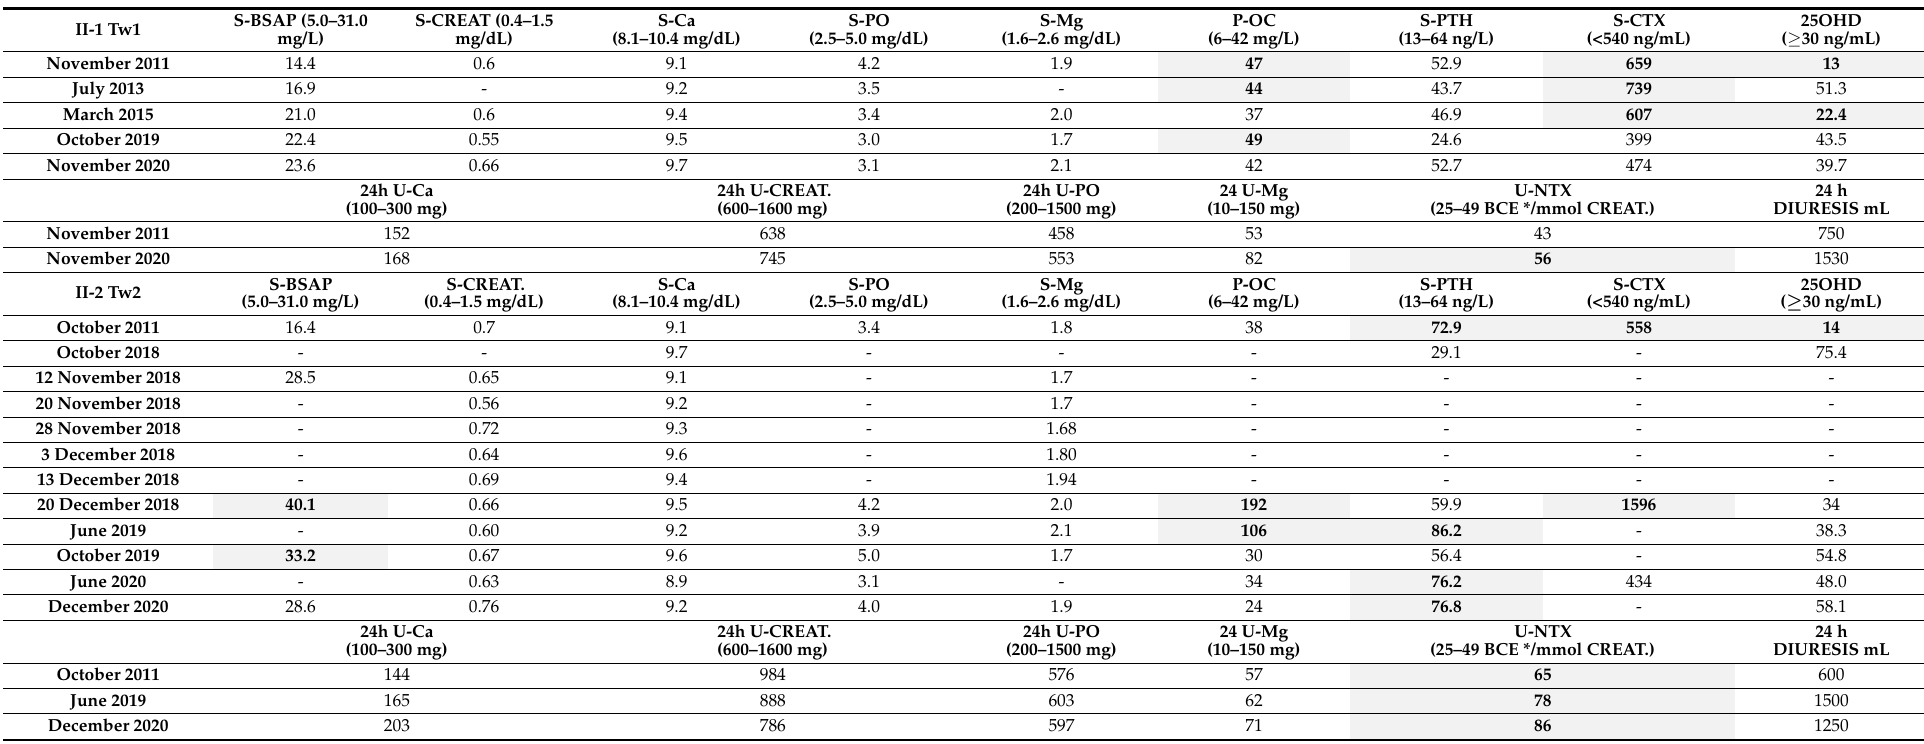
Table 2. II-1 Tw1 and II-2 Tw2 bone and mineral metabolism serum and urine results. In brackets, under each single biochemical parameter, the reference ranges of each are reported. In bold letters and gray background are reported results out of